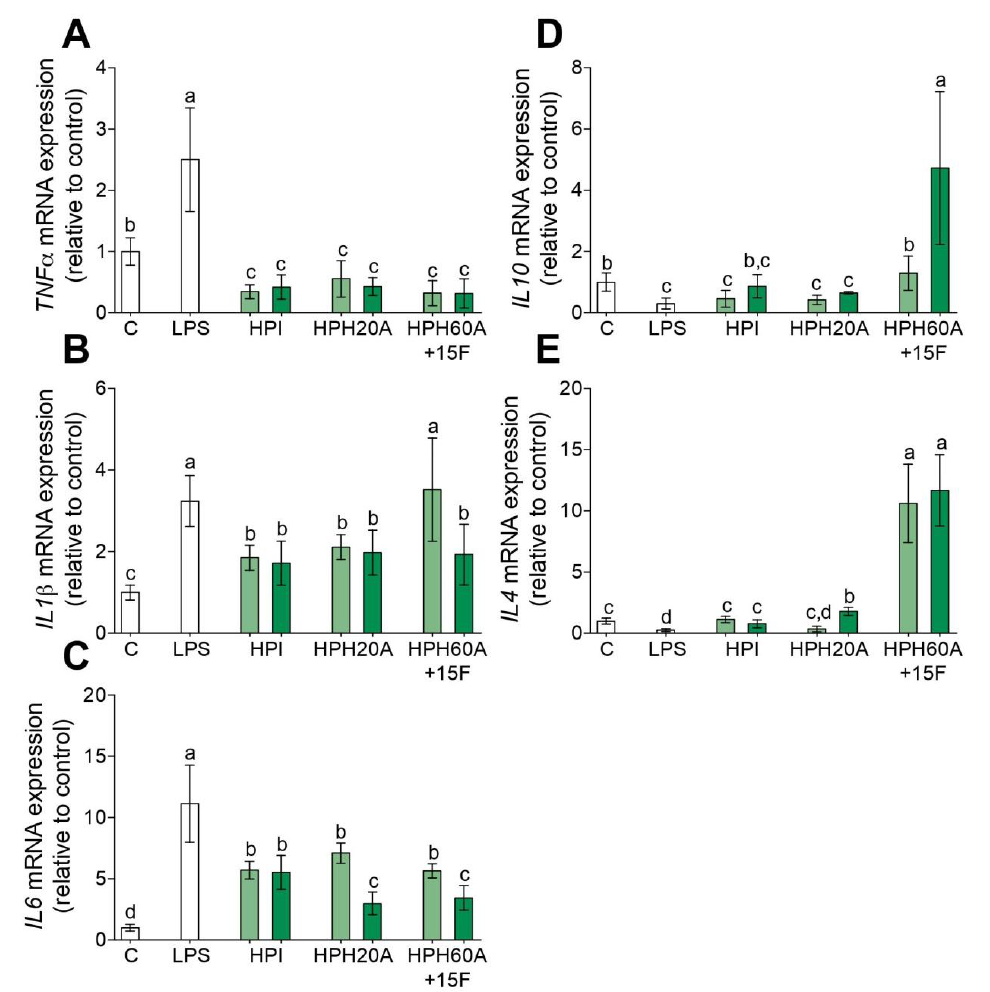
Figure 1. Effect of hemp protein products (HPPs) on inflammatory cytokine gene expression in LPS-stimulated primary human monocytes. Monocytes were treated with LPS (100 ng/mL) and then incubated with hemp protein isolate (HPI), HPH20A, and HPH60A15F at 50 (light green bar) and 100 (dark green bar) μg/mL for 24 h. Relative mRNA expression levels of TNF-α ( A ), IL-1β ( B ), IL-6 ( C ), IL-10 ( D ), and IL-4 ( E ) were detected by real-time quantitative PCR. Data are show as means ± SD ( n = 3) and the significantly different ( p < 0.05) are labeled with contrasting letters.